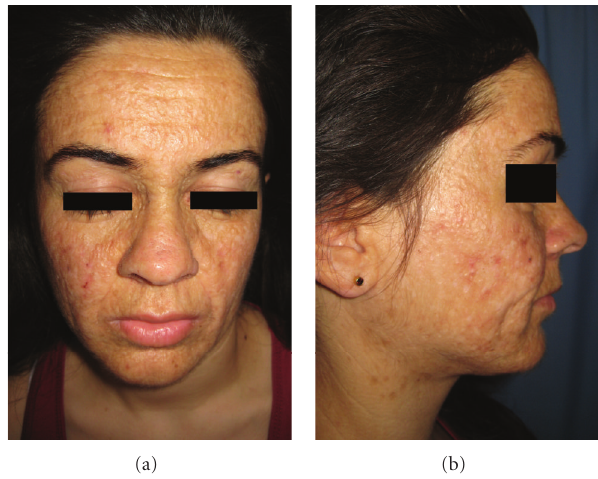
Figure 1: (a) Widespread, indurated flat papules and plaques. (b) Depressed acneiform scars more prominent on malar